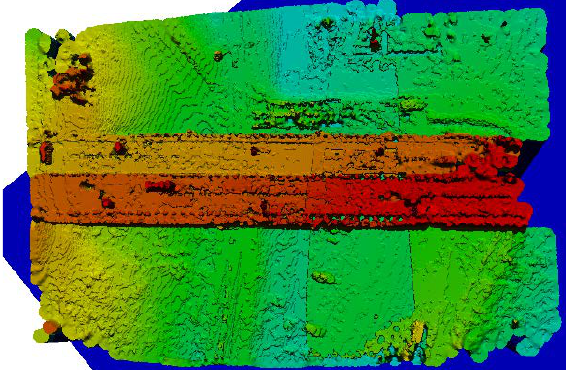
Figure 6. A DSM generated over entire ROI